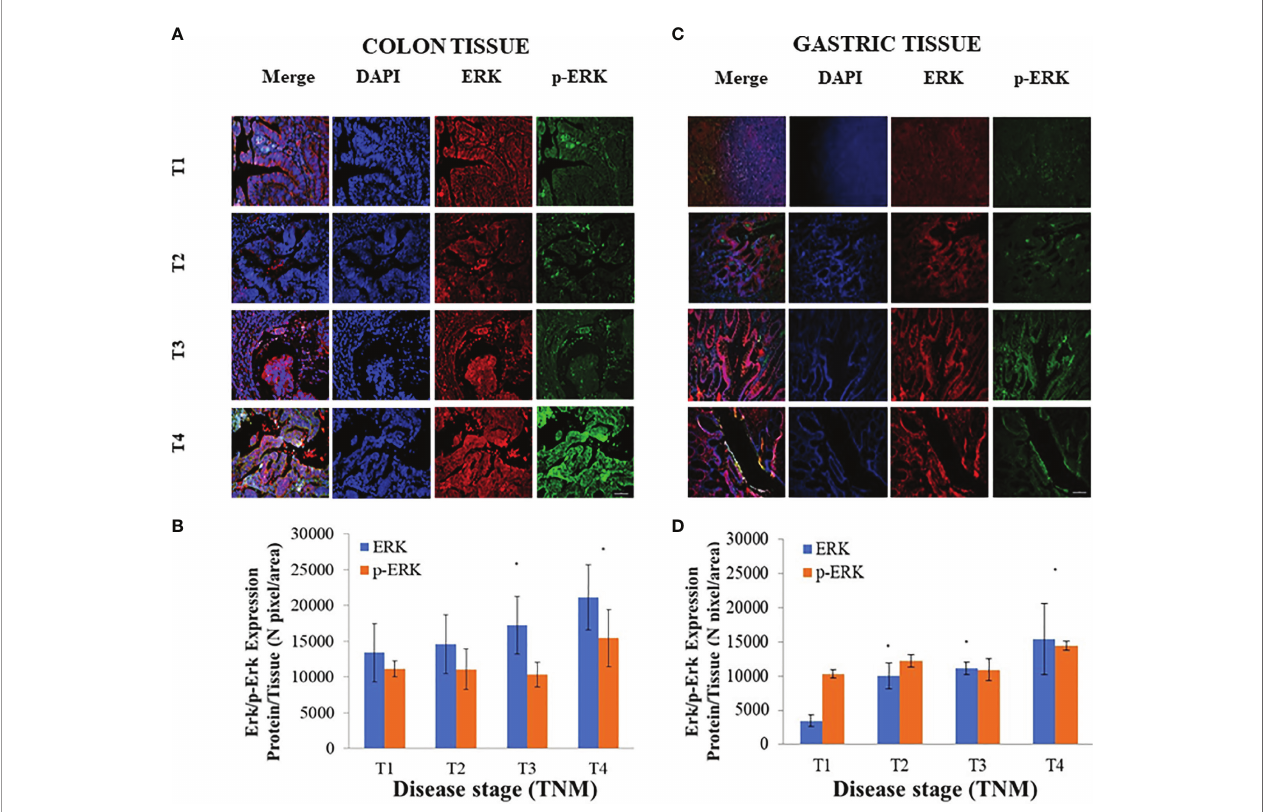
FIGURE 5 | Evaluation of extracellular signal-regulated protein kinase (ERK)1/2 and p-ERK1/2 expression levels in tissues derived from (26) colorectal cancer (CRC) or (20) gastric cancer (GC) patients. Representative confocal microscopy images (A, C) for the detection of ERK1/2 and p-ERK1/2, along with ERK1/2 and p-ERK1/ 2 expression levels (B, D) , evaluated by fl uorescence intensity index analysis, in CRC (A, B) and GC (C, D) tissues at different TNM stages. Blue channel: nuclei; green channel: labeled p-ERK1/2; red channel: labeled ERK1/2 and corresponding overlay. Scale bar, 50 µm; Magni fi cation, ×20. (*) p < 0.005 vs . CRC or GC patients with stage T1 (A – D)